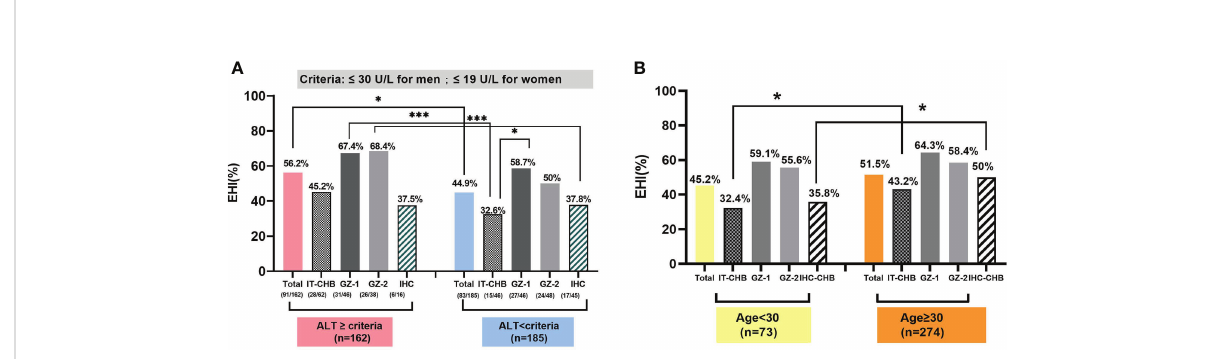
FIGURE 4 The effect of the change in antiviral therapy indication for age and ALT threshold in identifying EHI among those with chronic HBV infections. (A) Based on the new ALT threshold, IT and IHC patients presented a low EHI. (B) The proportion of EHI in patients more than 30 years old was 51.5%. Comparison of the proportion of EHI in each group, based on 30 years as the cut-off value.*p <0.05, ***p